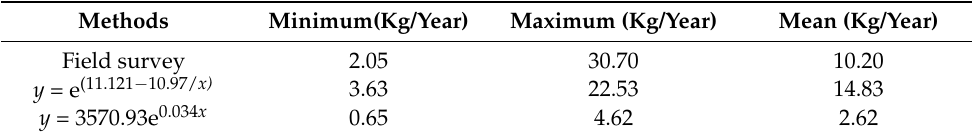
Table 2. Annual leaf litter amount per tree obtained by different methods.